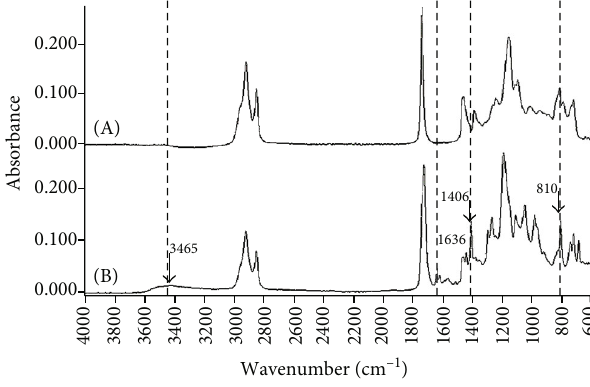
Figure 6: FTIR spectra of EPOP (EPO) and EPOLA (AEPO) (from Ashraf et al. [40], adapted).